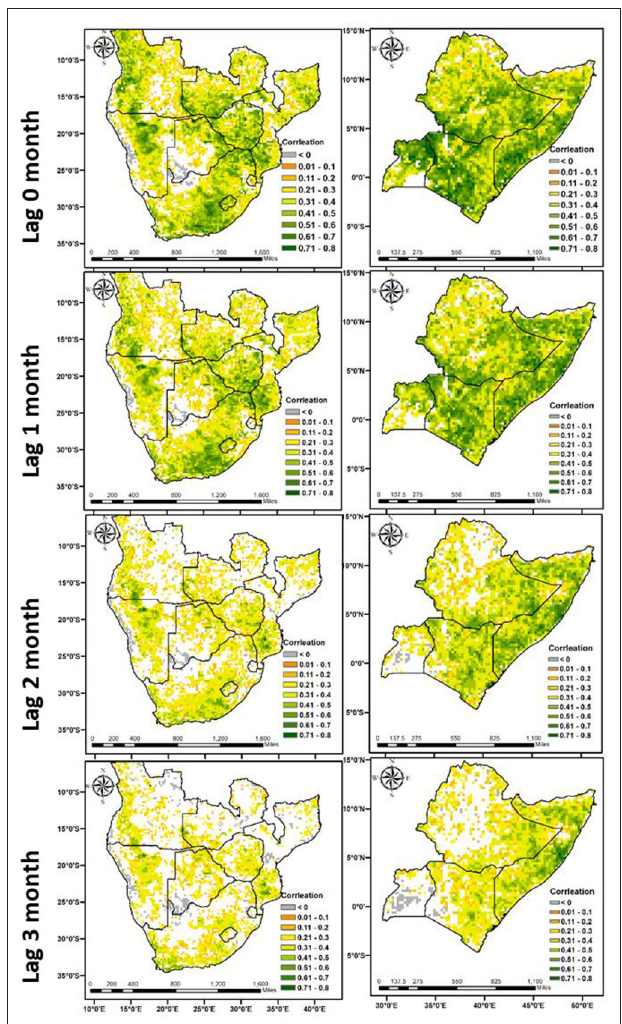
FIGURE 2 | Correlation coefficient between RZSM and NDVI anomalies for different lag times over Southern Africa (top) and Eastern Africa (bottom) for the study period of 2010–2019. The white areas are the pixels for which the correlation is not significant at the 90% level.